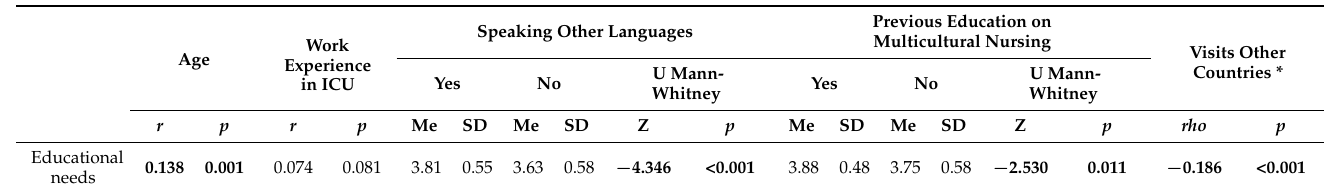
Table 5. Nurses sociodemographic characteristics and educational needs regarding multicultural nursing